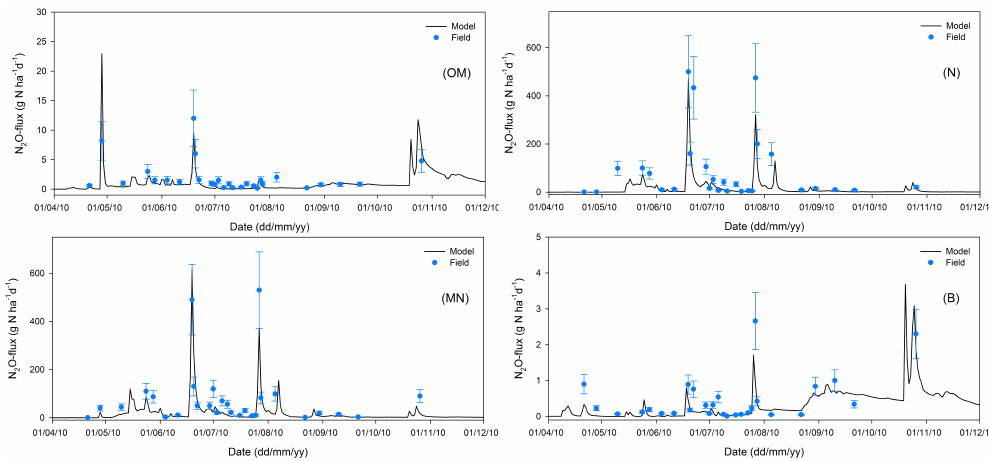
Fig. 3. Comparison of observed and modeled N 2 O emissions in summer maize fields.